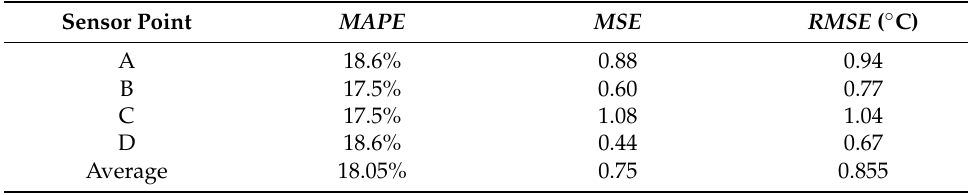
Table 6. Calibration results of temperature at four monitoring points.